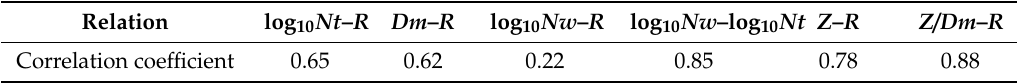
Figure 8. Scatterplots of Z / D m versus R and the fitted relationship for stratiform rainfall. The red dashed curve is the fitted curve for stratiform precipitation in Xinjiang. Correlation coe ffi cients for di ff erent empirical relations for the 2753 samples of stratiform